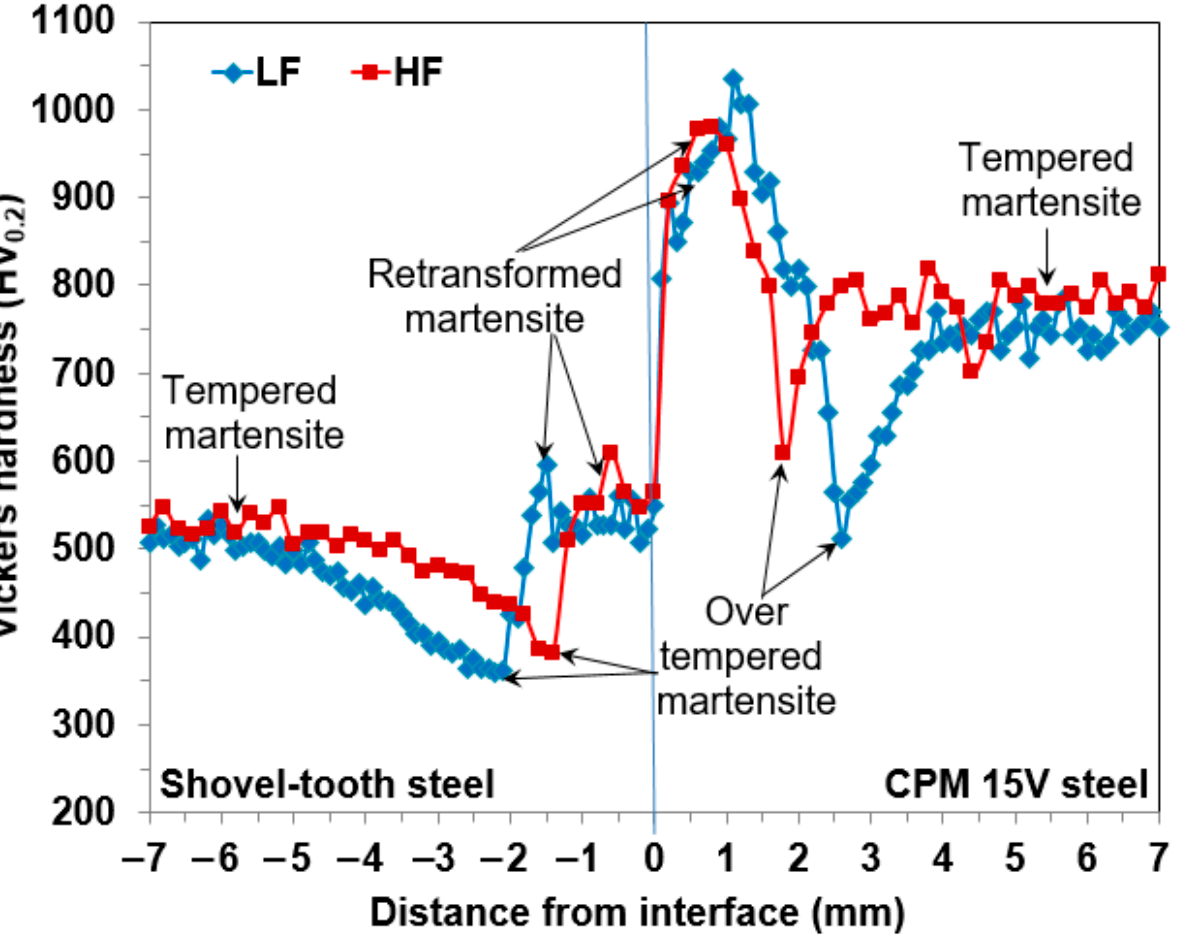
Figure 13. Hardness profile of each welded condition as a function of distance.